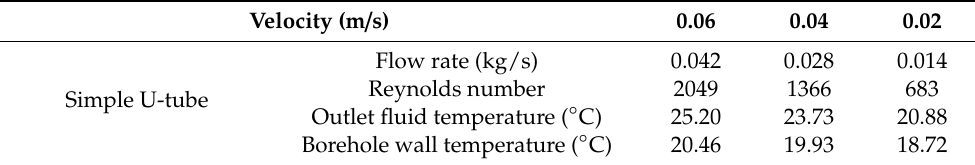
Table 6. Numerical results of simple and finned U-tube GHEs.